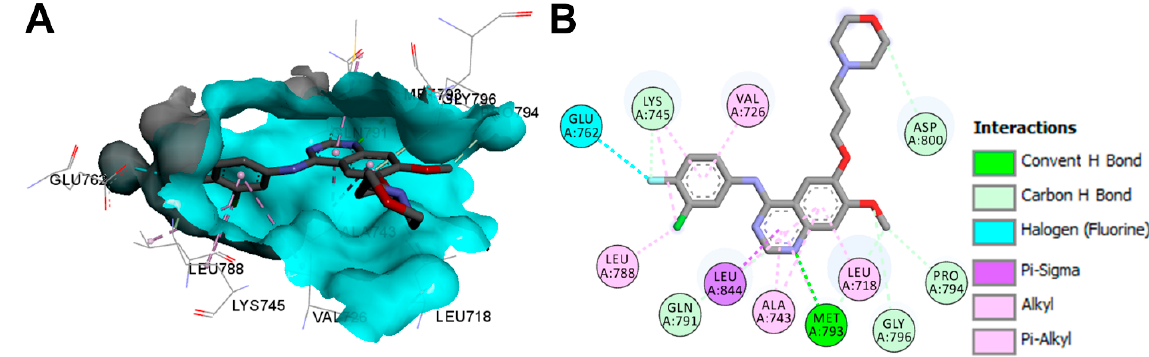
Figure 33. Binding modes of gefitinib (shown as sticks) into EGFR kinase domain L858R mutation (pdb: 2ITZ): ( A ) 3D binding mode, receptor shown as hydrogen bond surface; ( B ) 2D binding mode showing different types of binding interactions; the figure was generated using Discovery Studio Visualizer (V16.1.0.15350).